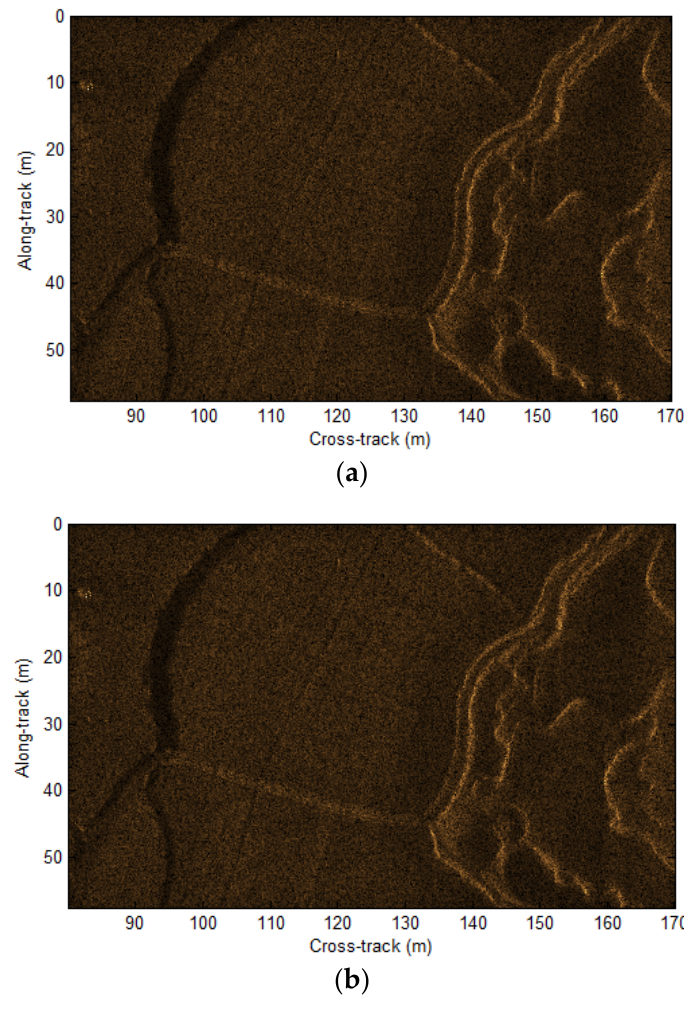
Figure 11. Real ‐ data processing results with presented method. ( a ) Upsampling rate of 2; ( b ) up ‐ Figure 11. Real-data processing results with presented method. ( a ) Upsampling rate of 2; sampling rate of 8. ( b ) upsampling rate of